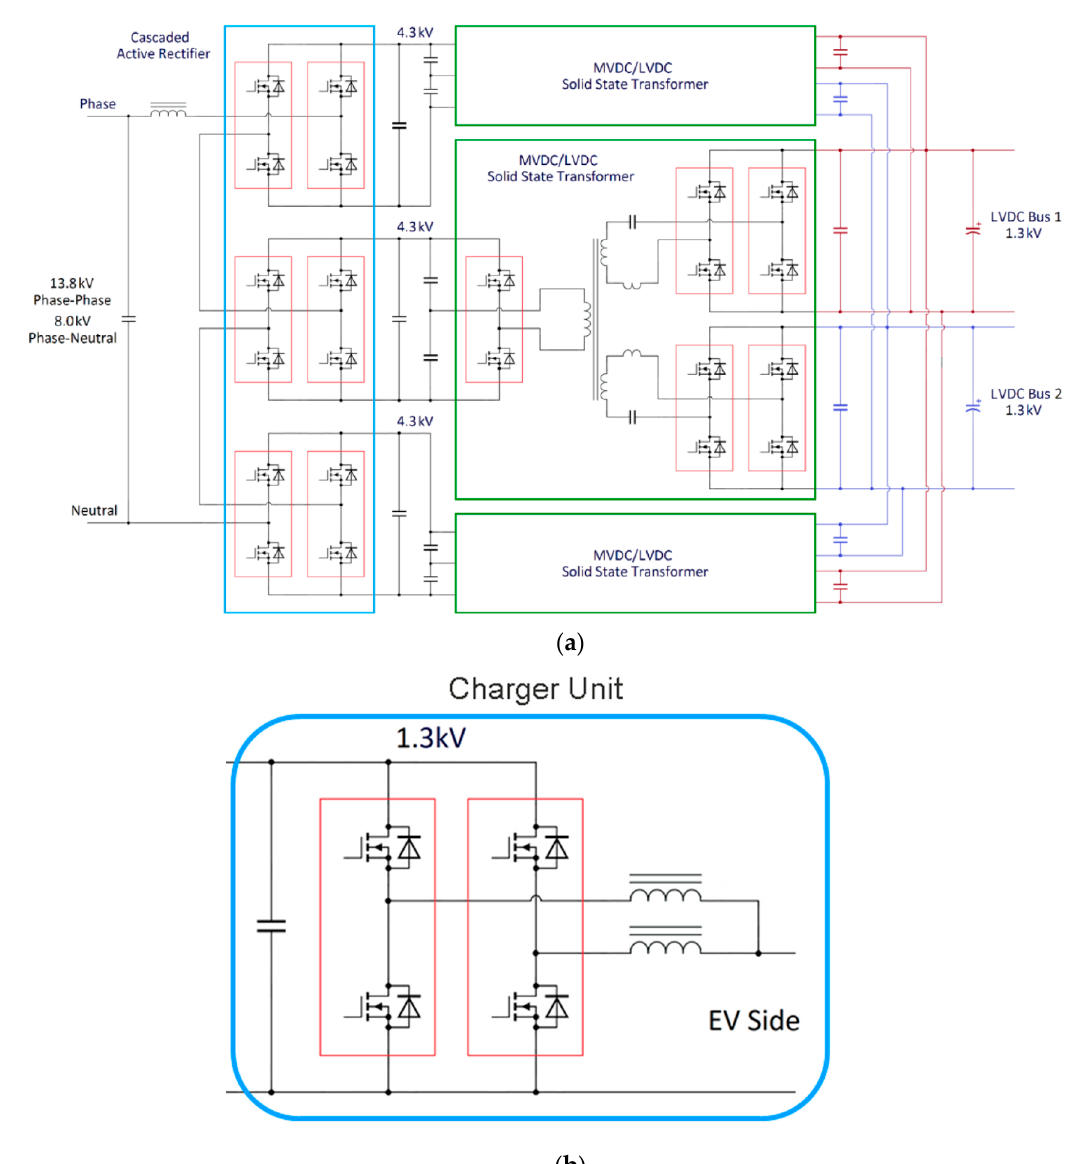
Figure 1. ( a ) Block Diagram of proposed design of electric vehicle (EV) extreme fast charger (XFC) station for two vehicles. ( b ) Block diagram of the following 500 kW DC/DC converter.